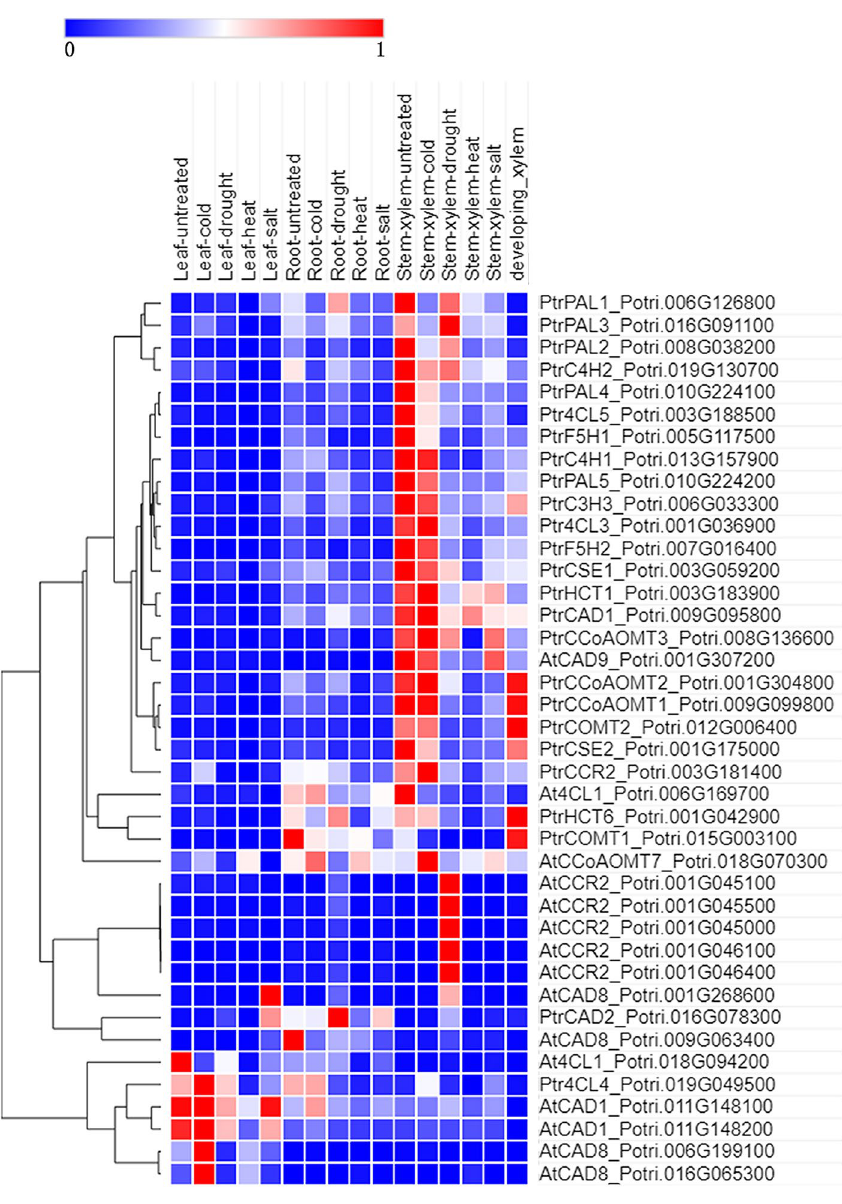
Figure 3. Hierarchical clustering of the expression profiles of lignin biosynthesis pathway genes in different tissues of Populus trichocarpa